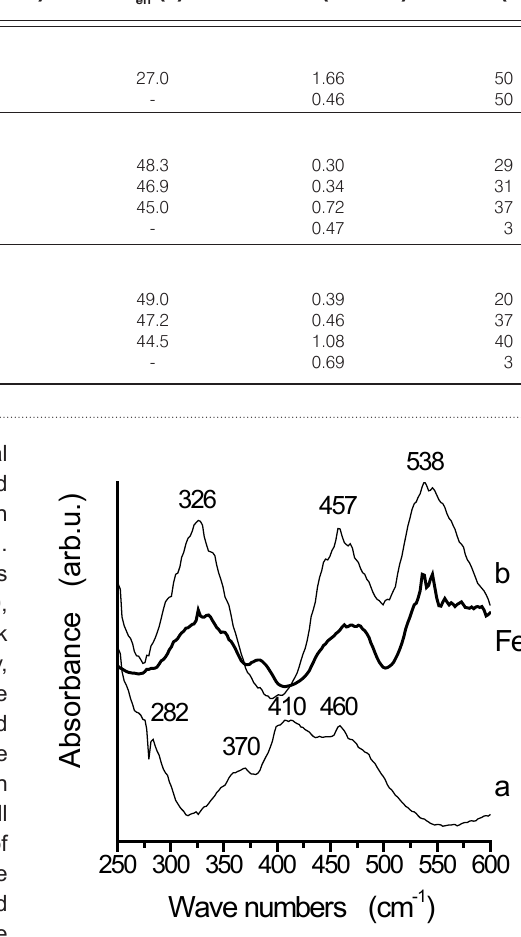
Figure 3. Far-IR spectra from KBr pellet of the initial biomass sample (a) and after its treatment in Ar flow at 250° С (b). Spectrum of hematite Fe O is shown for 2 3